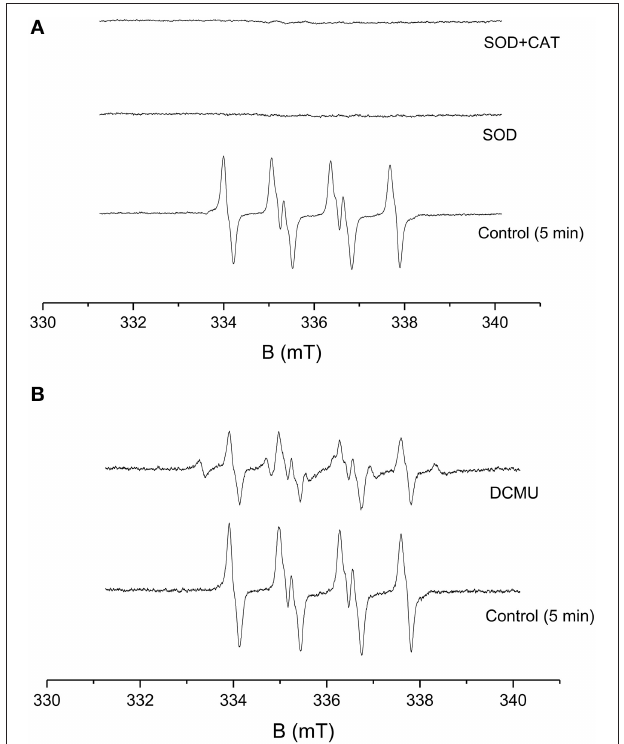
FIGURE 2 | Effect of SOD, CAT, and DCMU on EMPO-OOH adduct EPR spectra measured in PSII membranes. EMPO-OOH adduct EPR spectra were measured in PSII membranes in the presence of SOD and CAT under light illumination. The relative intensity of the light-induced EMPO-OOH adduct EPR signal measured in the presence of SOD (400U/ml) and SOD + CAT (400U/ml each) (A) and DCMU (20 µ M) (B) . The other experimental conditions were the same as described in Figure 1